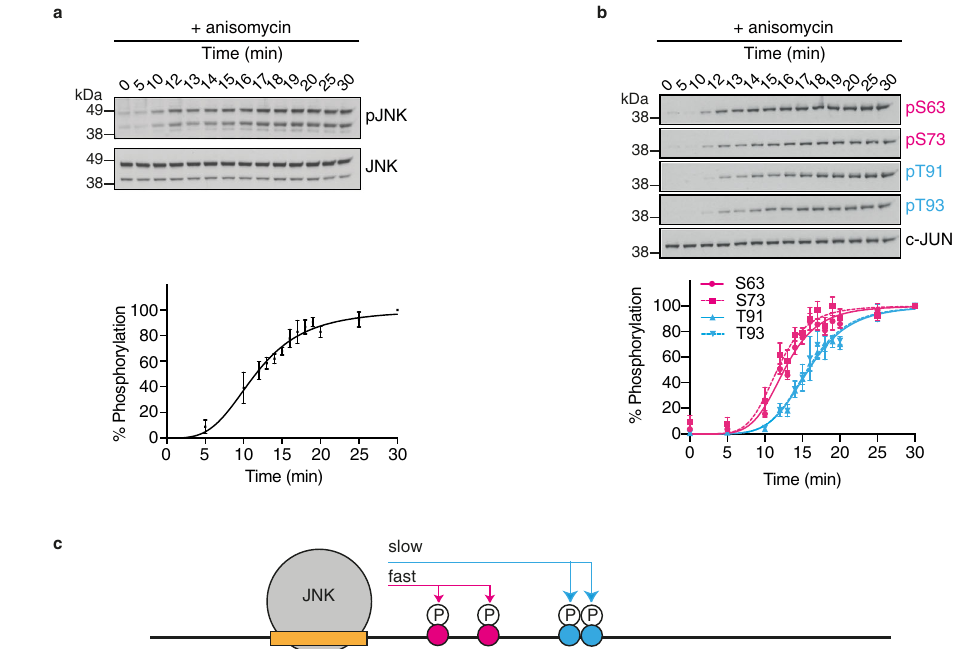
Fig. 2 | Kinetics of the c-JUN N-terminal phosphorylation in vivo. a Representative Western blot analysis of the phosphorylation (activation) of endogenous JNK in NIH3T3 cells following anisomycin treatment (top), and quan- ti fi cationofthedetectedproteinlevelsusingtheImageStudioLiteSoftware(Licor) and normalized to total JNK. Graphs show the mean±standard error of the mean (SEM) ( n =3 biologically independent experiments) (bottom). b Representative western blot analysis of the phosphorylation kinetics of endogenous c-JUN in NIH3T3 cells following anisomycin treatment using phosphorylation-speci fi c